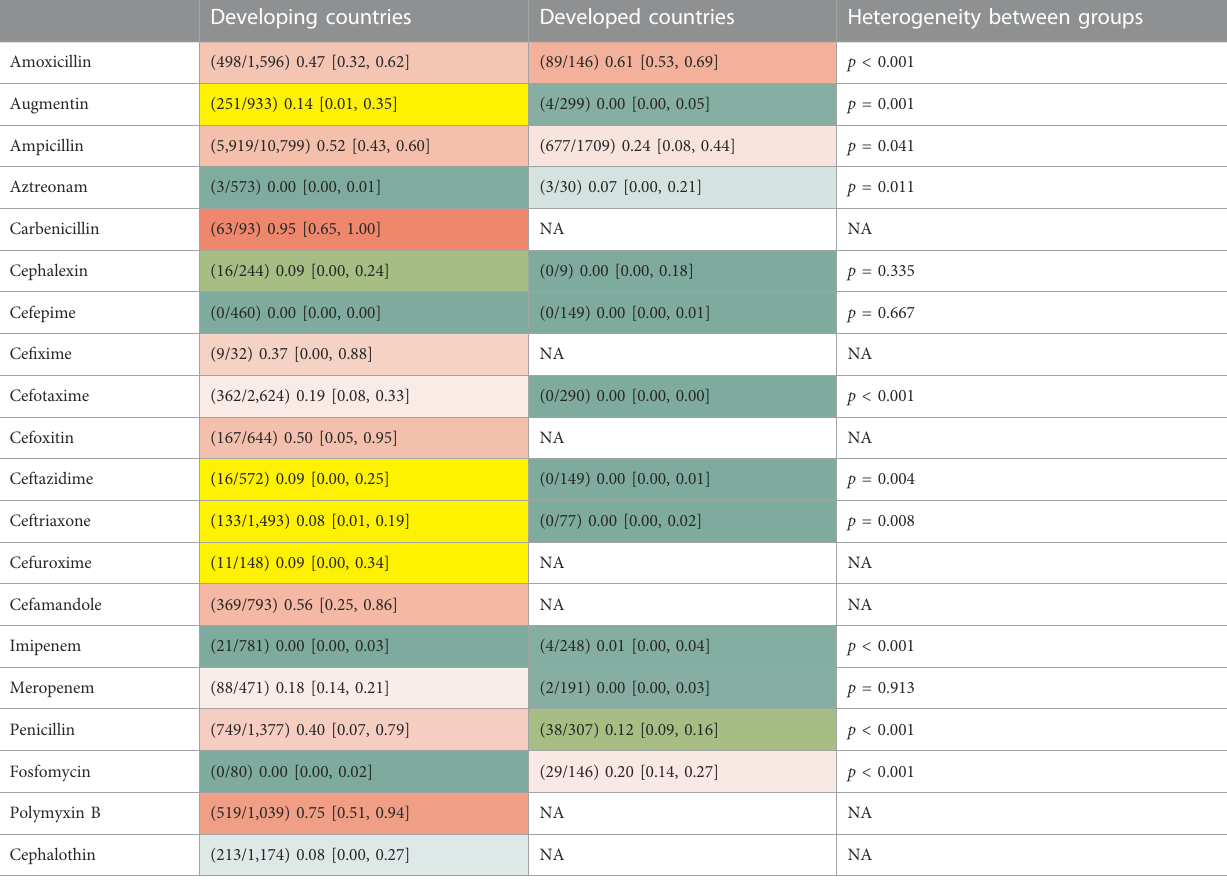
Legend: The heatmap of weighted pooled proportions of